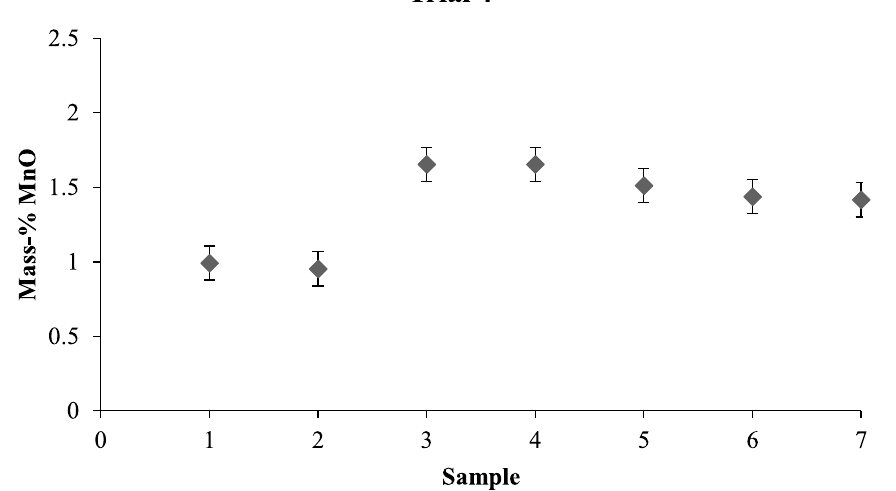
Figure 4. Content of MnO (%) for all the samples taken during Trial 4, where samples 1 and 2 were taken before tracer addition and the rest of the samples were taken after tracer addition.